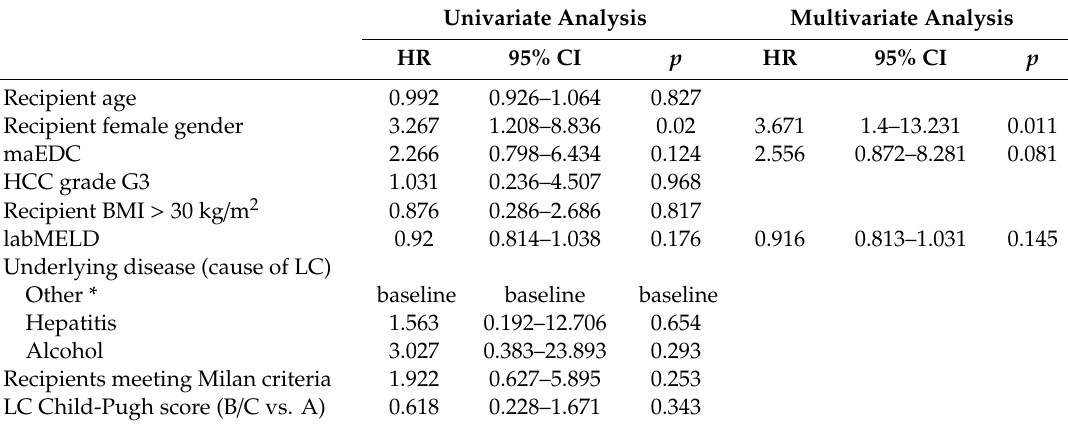
Table 6. Univariate and multivariate cox regression analyses of factors associated with 1-year patient